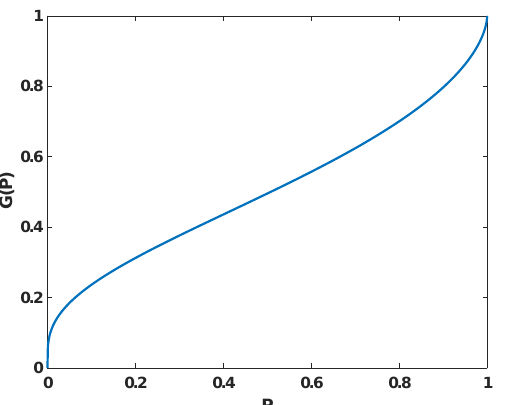
Figure 1. Example of a probability weighting function in the form of G ( P ) = exp ( − ( − β ln ( P )) α ) , introduced by Prelec (1998), with parameters α = 0.6 and β =